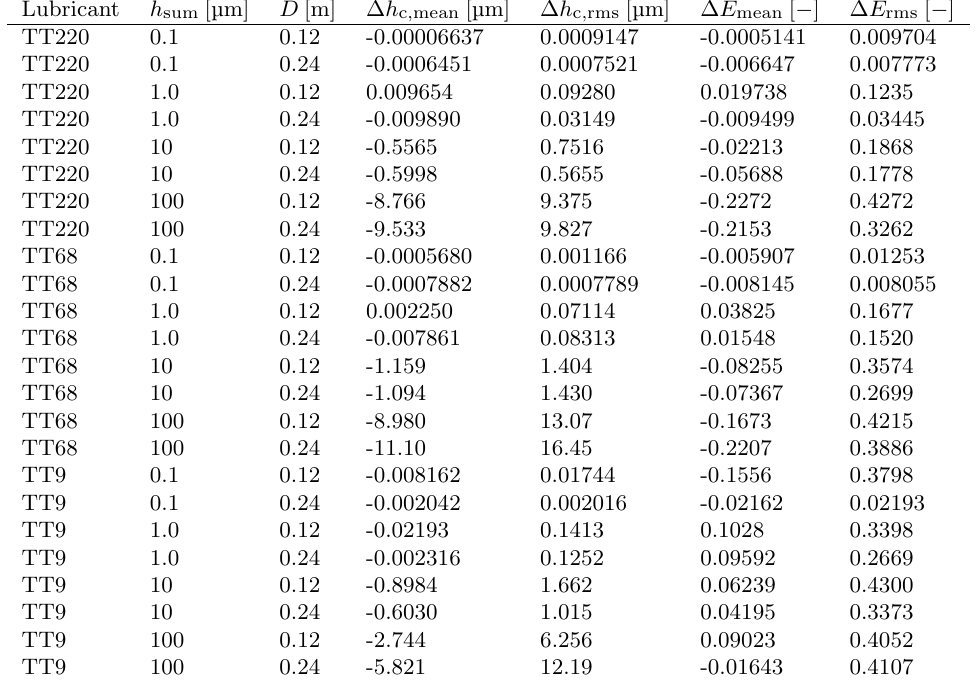
Table 2: Absolute and relative differences in central film thickness between transient Reynolds and EHL for- mula. This in each case for all three sum velocities [0 . 4 , 4 . 0 , 40 . 0] m / s, and all three line load levels [300 , 3000 , 30000] N / m. In total there are 216 test cases. The Shell type lubricant is at 40 ◦ C. Lubricant h sum [ µ m] D [m] ∆ h c,mean [ µ m] ∆ h c,rms [ µ